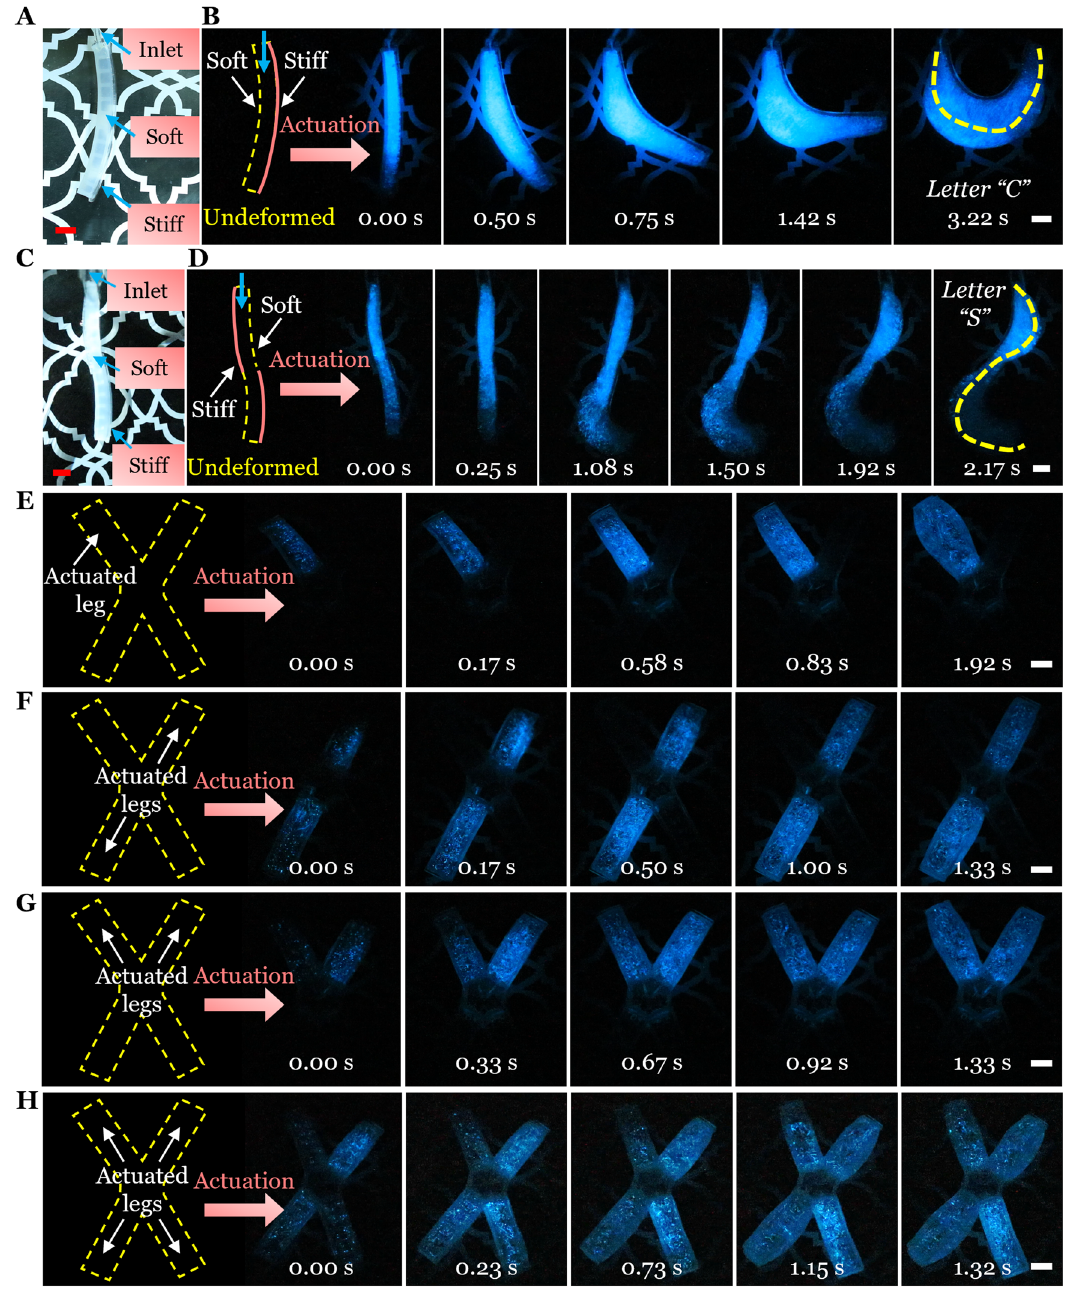
Fig. 6 Optical signaling by the actuation of the biohybrid mechanoluminescent actuator/robot in the dark. A Soft uni-directional bending actuator. B Actuation-induced optical signaling of the actuator in the dark. The actuator was composed of a soft in fl atable part and a stiff constraining layer. Upon hydraulic actuation, the soft actuator bent to show a bright letter “ C ” . C Soft bidirectional bending actuator. D Actuation-induced optical signaling of the actuator in the dark. The actuator was constructed by connecting two uni-directional bending actuators shown in A. Upon hydraulic actuation, two segments bent to opposite directions to show a bright letter “ S ” . E – H Actuations of the four legs of a soft robot in different sequences to show different bright patterns for optical signaling. All scale bars are 1